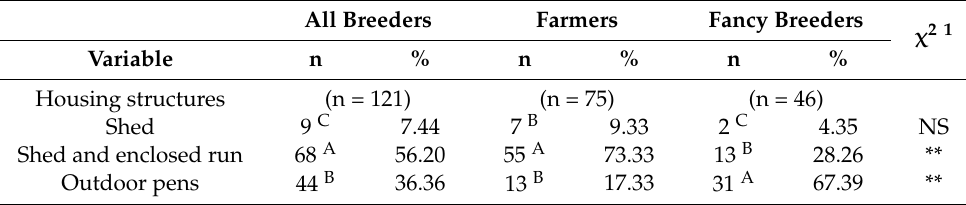
Table 5. Types of housing structures used: responses from all breeders and divided according to breeder